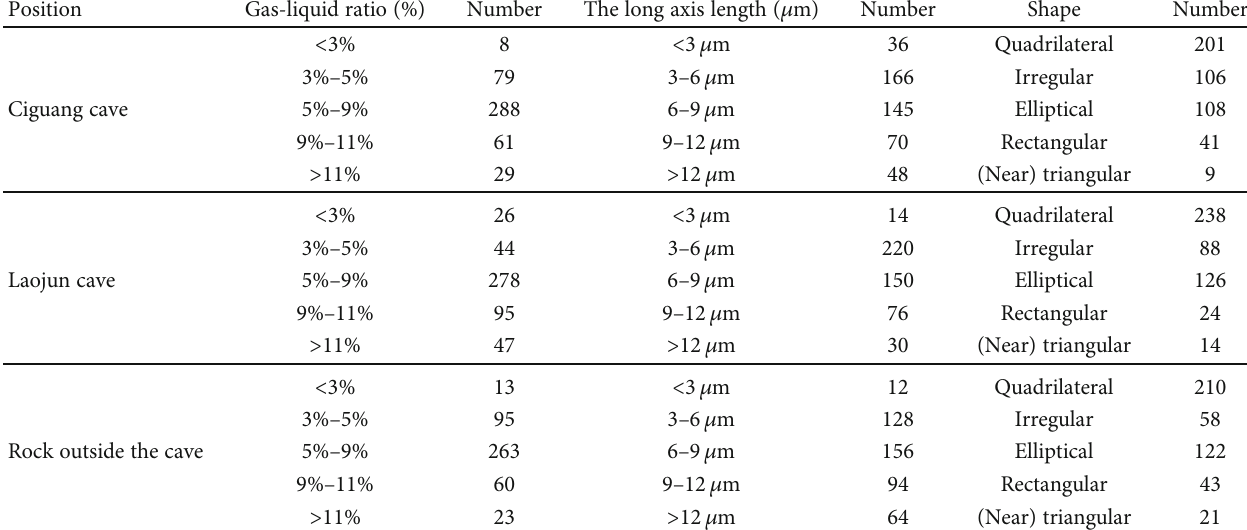
Table 1: Petrography characteristics of fl uid inclusions.